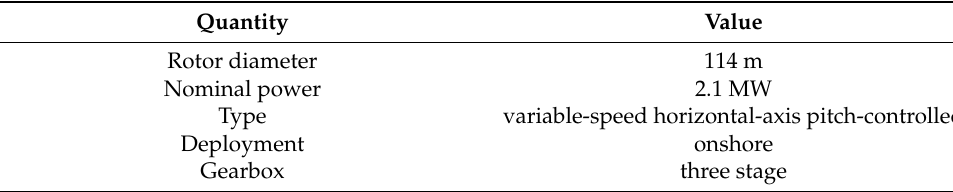
Table 1. Technical specifications of the two commercial wind